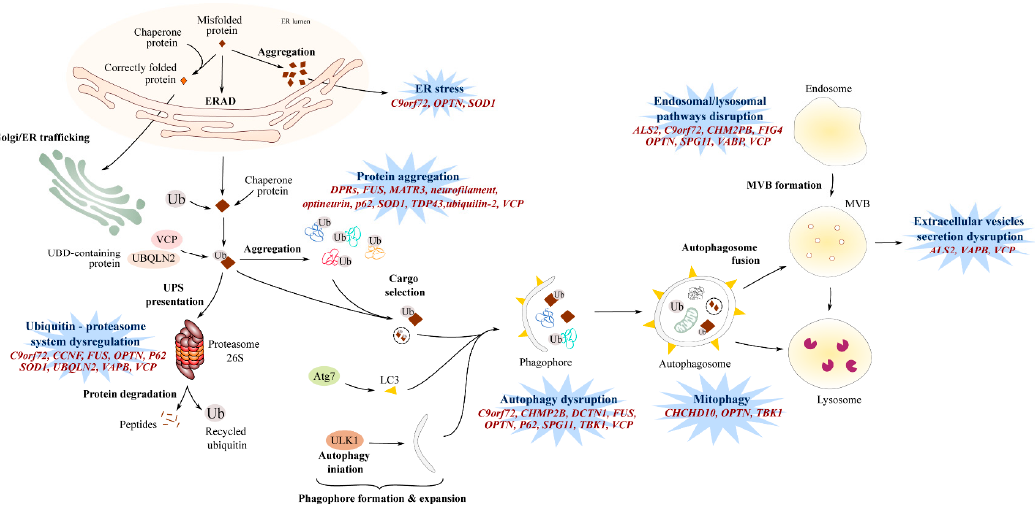
Figure 2. Protein homeostasis dysregulation. Dysregulated protein homeostasis is mediated by multiple pathways encompassing defects in autophagy, the dysregulated ubiquitin-proteasome system (UPS), endo-lysosomal pathway disruptions, or endoplasmic reticulum (ER) stress. The presence of misfolded proteins activates endoplasmic reticulum-associated protein degradation (ERAD), leading to proteasome-mediated degradation to avoid misfolded protein accumulations in the ER lumen and subsequent ER stress. Several ALS-associated gene mutations induce proteasome-mediated toxicity via the sequestration of ubiquilin and chaperone proteins involved in the UPS pathway. The proteolytic activity of the proteasome has also been demonstrated to be targeted by gene mutations in ALS. The autophagic pathway involves the formation and maturation of phagophores that engulf selected transported-cargo and form autophagosomes. Fusion with the lysosome enables the degradation of autophagosome contents. Defects in autophagy initiation and expansion, dysregulated phagophore formation, and/or impaired cargo transport are observed in ALS patients. Mutations in ALS-associated genes also cause defects in mitophagy, a specific form of autophagy. Defects in the endolysosomal have been associated with ALS gene mutations, including defective endolysosomal trafficking and altered lysosomal hoemostasis and degradation. Defects in the autophagy/lysosomal pathway may affect